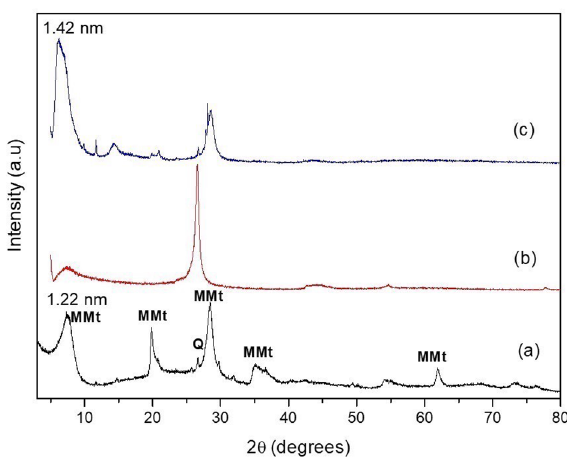
Figure 1. X-ray diffractograms: ( a ) MMt; ( b ) GO; and ( c )